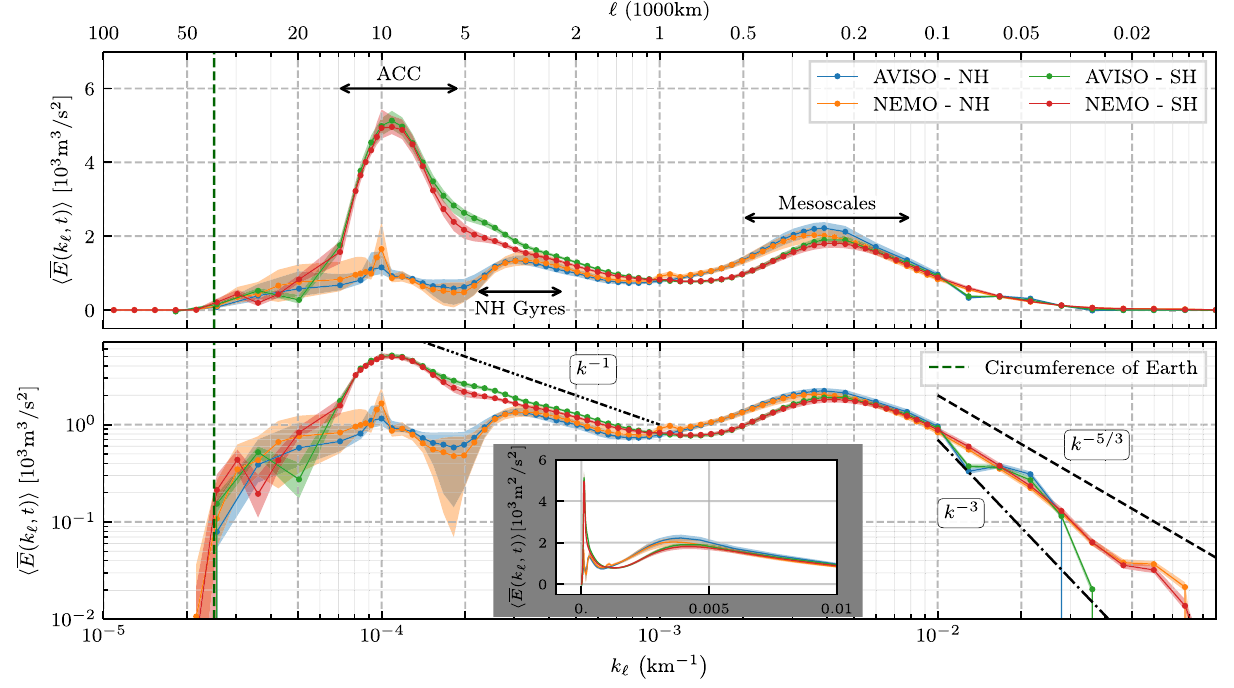
Fig. 2 | Power spectral density. Filtering wavenumber spectra (see Eq. (2)) of surface geostrophic KE for the global extratropical ocean from AVISO satellite altimetry and NEMO model re-analysis. Northern and southern hemispheres (NH and SH, respectively) extend poleward of 15°. The panels show the same data, but using [top] lin – log, [bottom] log – log, and [inset panel] lin – lin axes. Plots show the